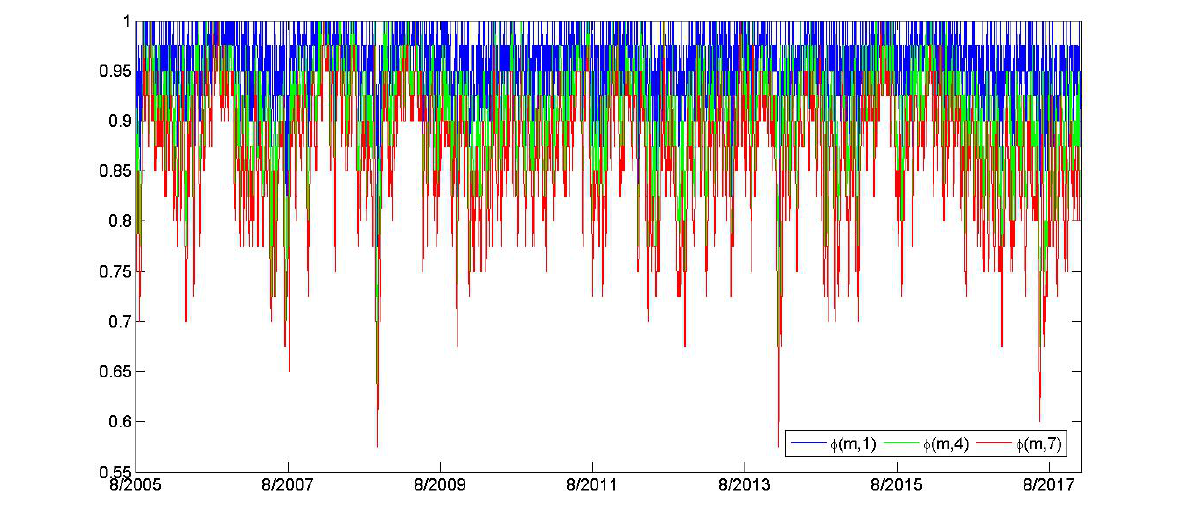
Figure 13. Survival ratio under different